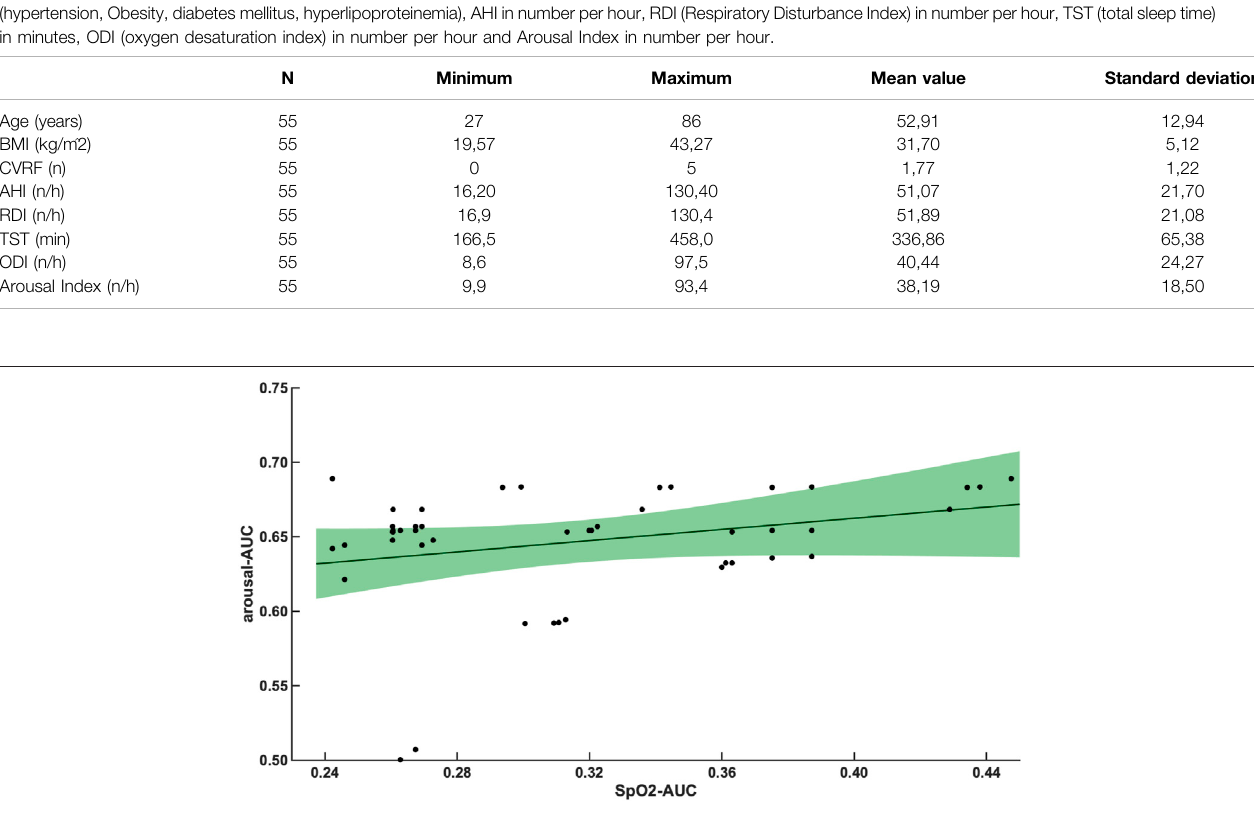
FIGURE 3 | Shows the linear regression results between the arousal-AUC and SpO2-AUC for patients with AHI 15 – 30/h of TST. The green margins indicate the standard deviation for the correlation and the black dots indicate each subject in this group. r = 0.280/ p = 0.056/ n =